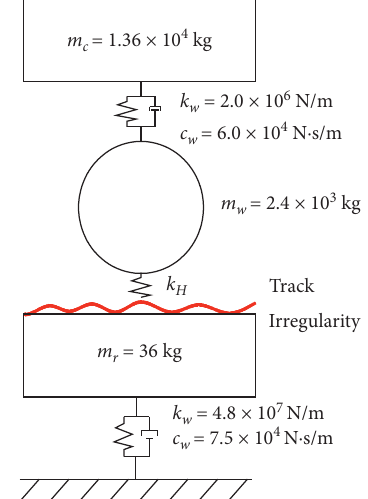
Figure 2: Simple model of the train-track